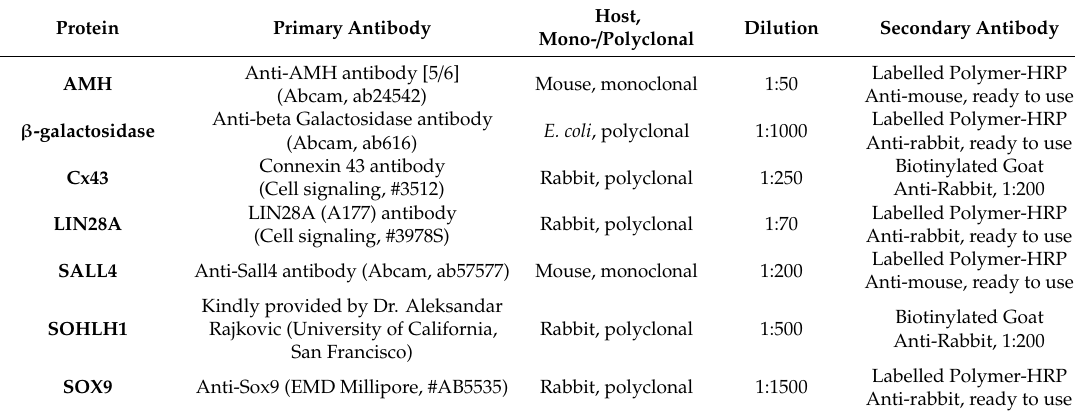
Table 1. Antibodies used for